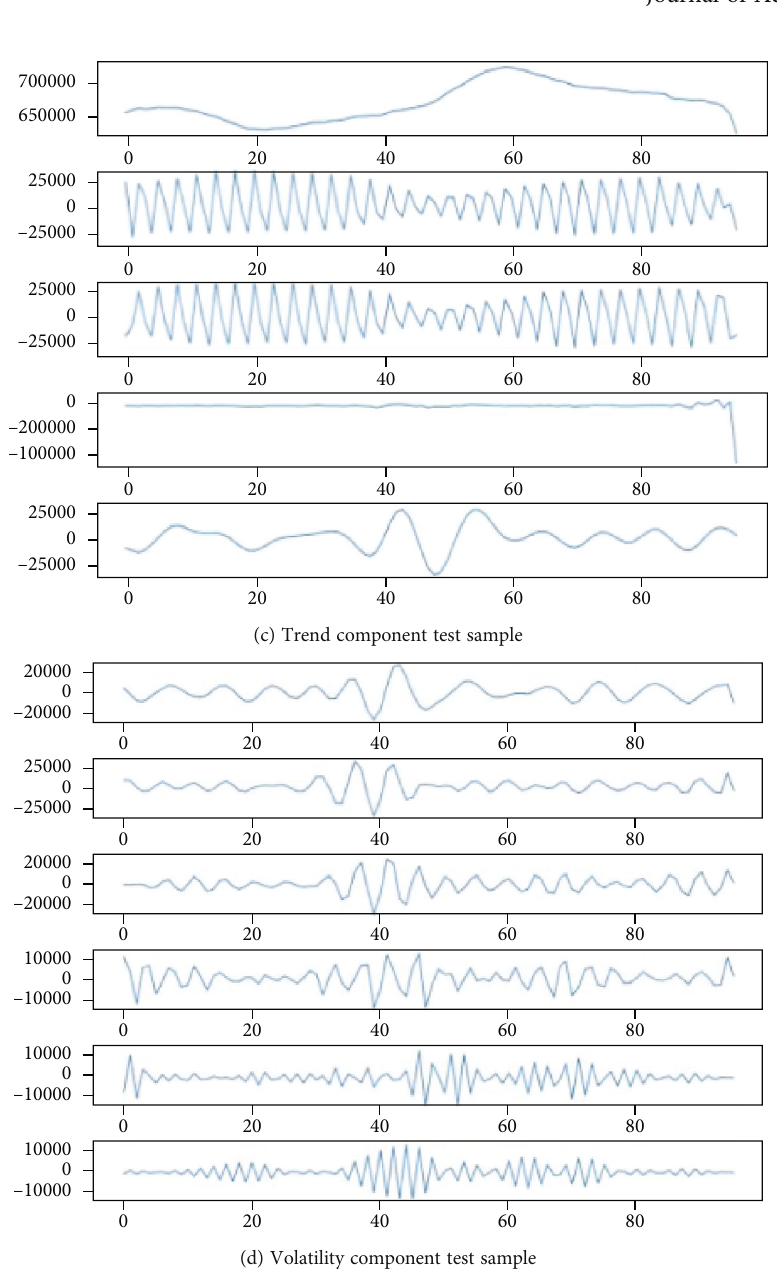
Figure 6: Training samples and test samples of passenger fl ow sequence data 2. Table 1: SDS-SSA-LSTM model parameters. Model